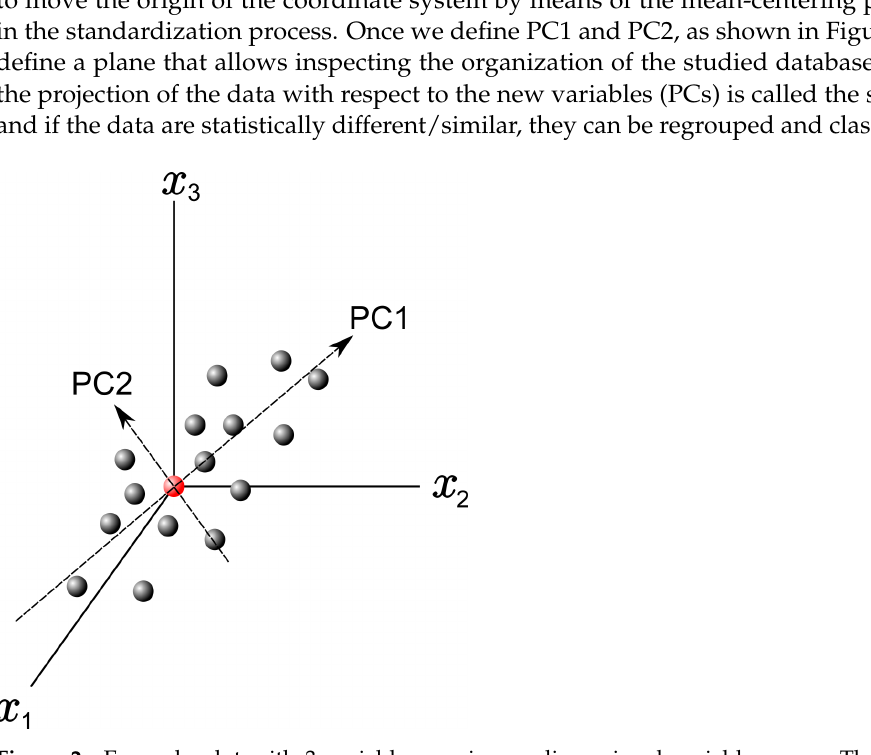
Figure 2. Example plot with 3 variable axes in a n-dimensional variable space. The principal components PC1 and PC2 are